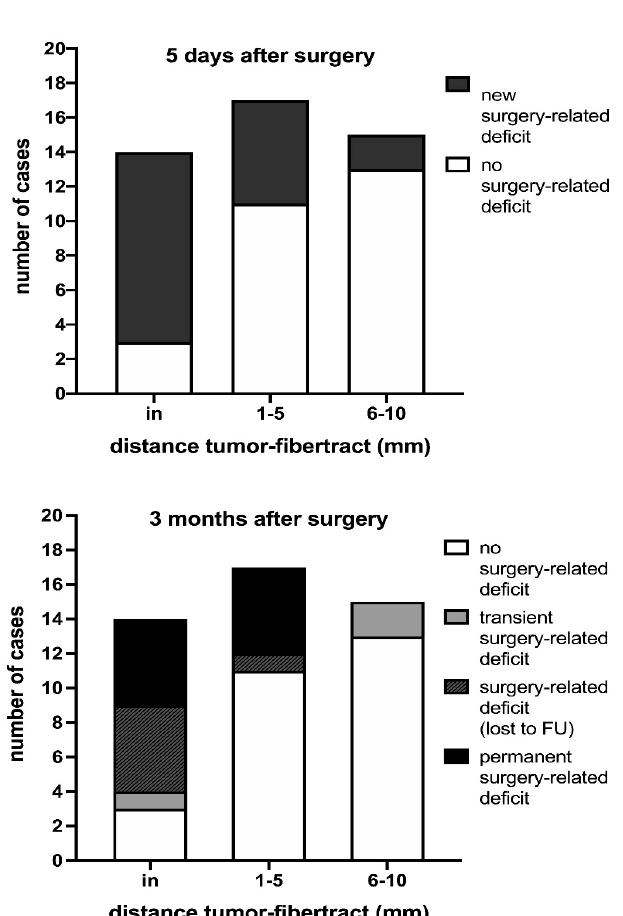
Figure 3. Prevalence of surgery-related deficits in relation to the distance between motor eloquent fiber tracts to the intraoperative MRI resection cavity. This figure outlines the surgery-related decrease in motor function in relation to the distance between the resection cavity and motor eloquent fiber tracts. Surgery-related motor deficits are significantly lower for distances of 1–5 mm and 6–10 mm ( p = 0.029 and p = 0.001, respectively) compared with patients with motor eloquent fiber tracts located in the resection cavity. Similar results were found for permanent surgery-related motor deficits, including patients lost to follow-up, for distances of 1–5 mm and 6–10 mm ( p = 0.073 and p < 0.001, respectively).